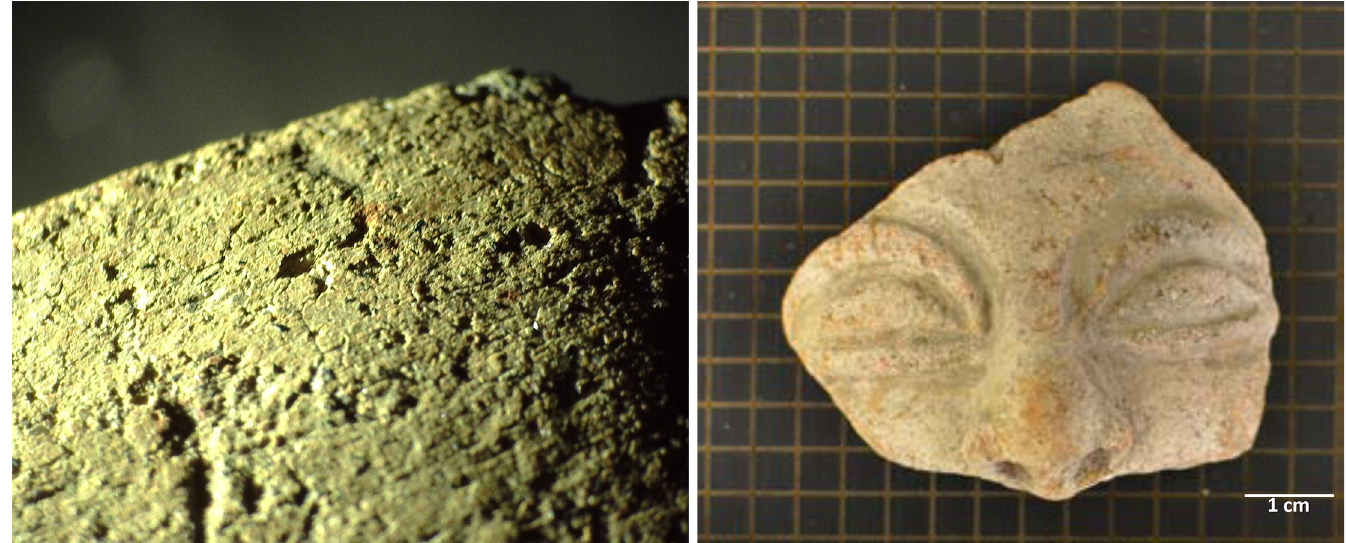
Fig 13. Evidence of finishing on the analyzed fragments. A. Traces of fine and regular polishing observed in IN05 used to smooth the surface of the piece. B Presence of slip in CO08.